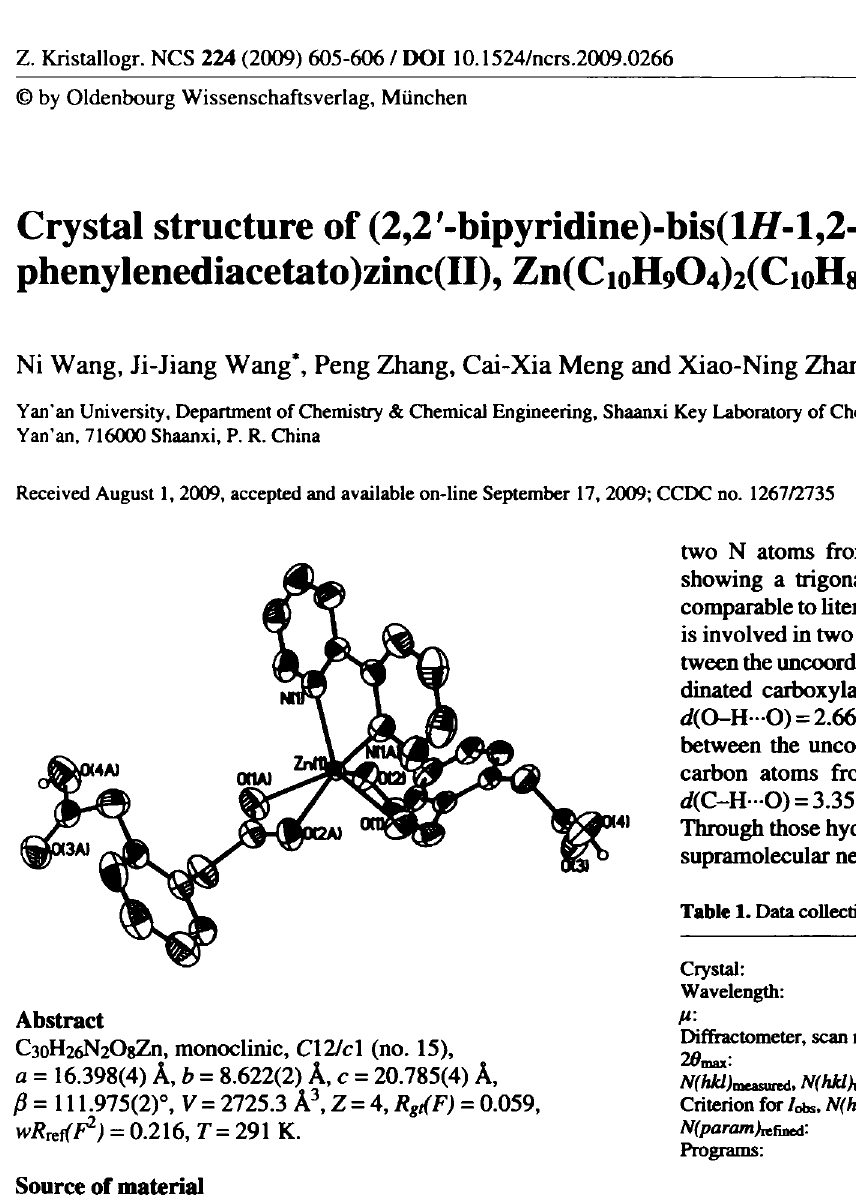
Table 2. Atomic coordinates and displacement parameters (in Â 2